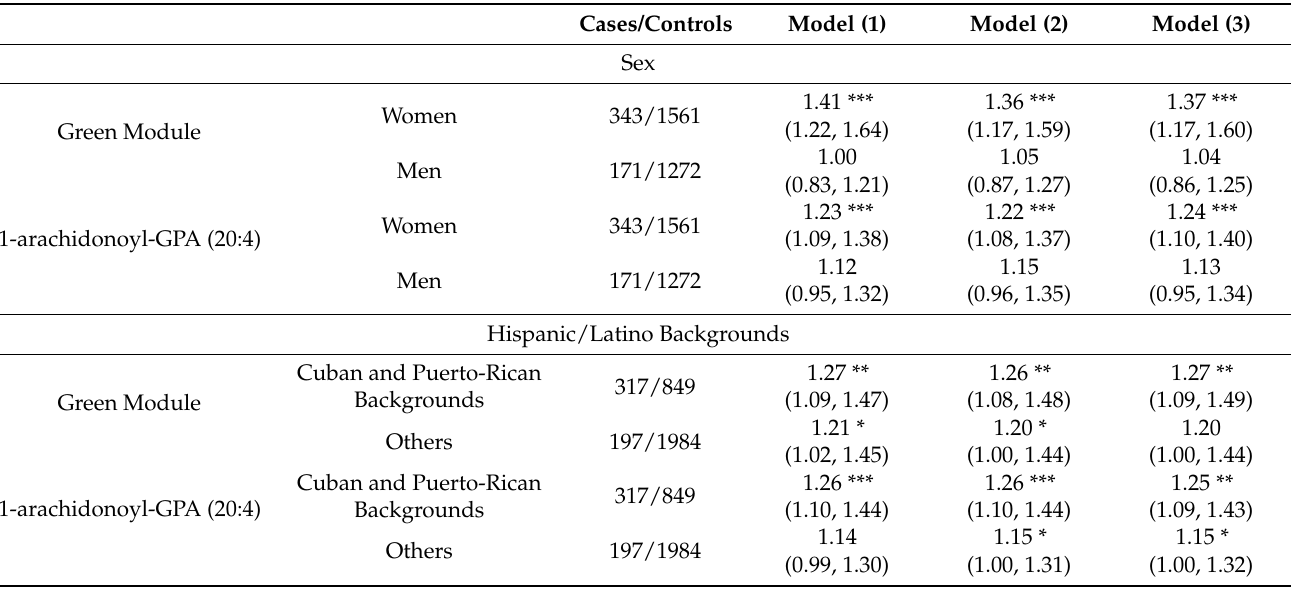
Table 3. Stratification Analysis of Green Module and 1-arachidonoyl-GPA (20:4) by Sex and His- panic/Latino